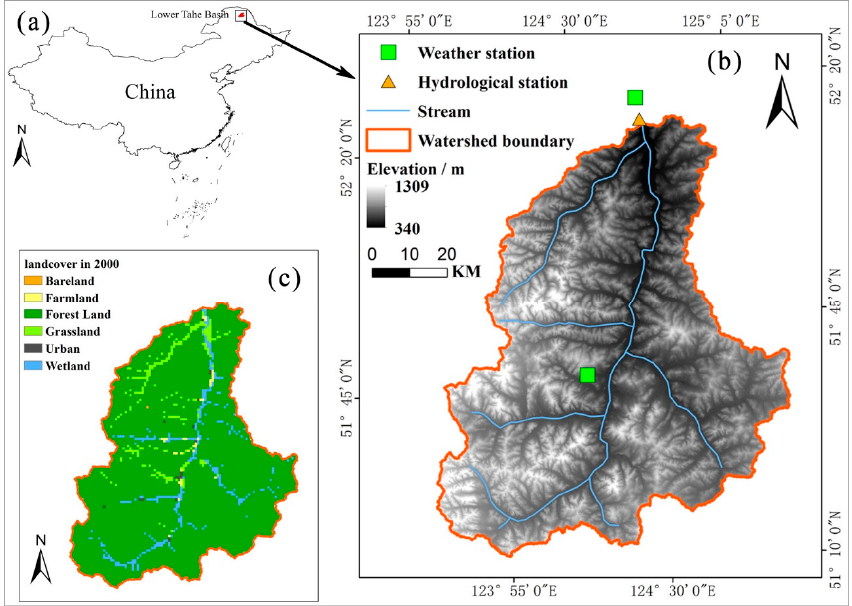
Figure 1. ( a ) Location of the study watershed in China, ( b ) Two meteorological stations, hydrological station, and Digital Elevation Model (DEM) of the Tahe watershed, and ( c ) Land cover in 2000.